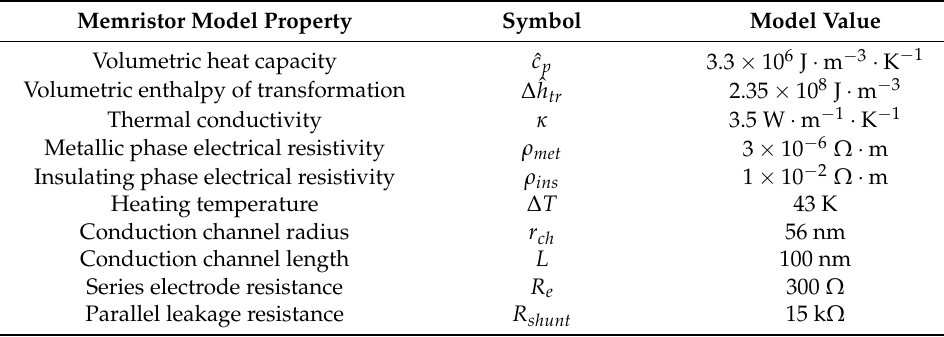
Table 2. The Parameters of Equation